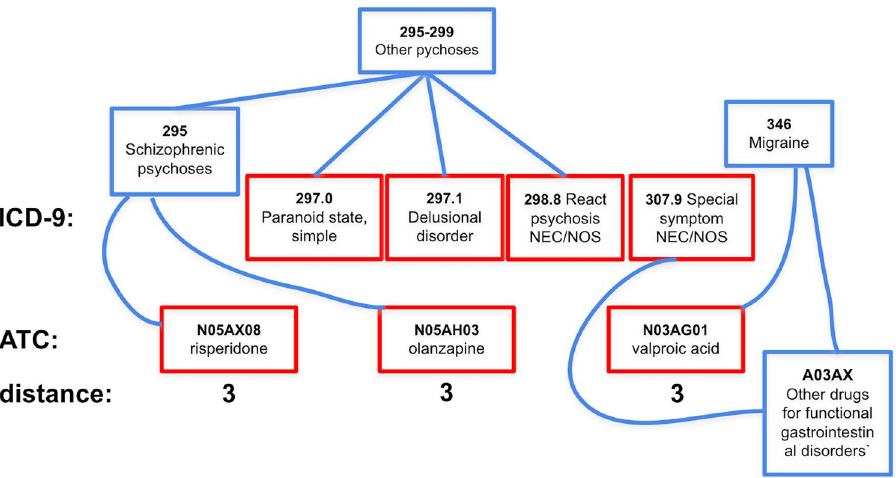
Figure 3. An example of the imputed ATC drugs for a patient. Codes in red frames are observed ICDs and imputed ATCs. The three imputed ATCs are of the same distance to observed ICDs, while their shortest paths may